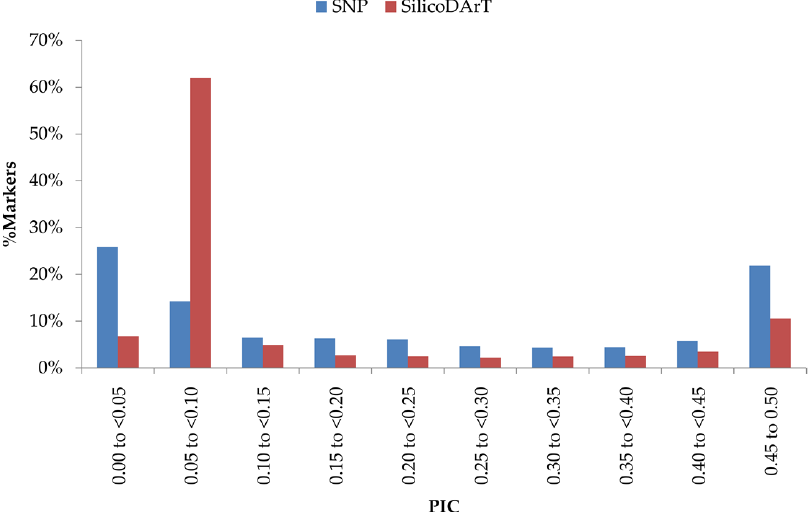
Figure 1. Distribution of PIC values of SilicoDArT and SNP markers used for genomics studies in cowpea.